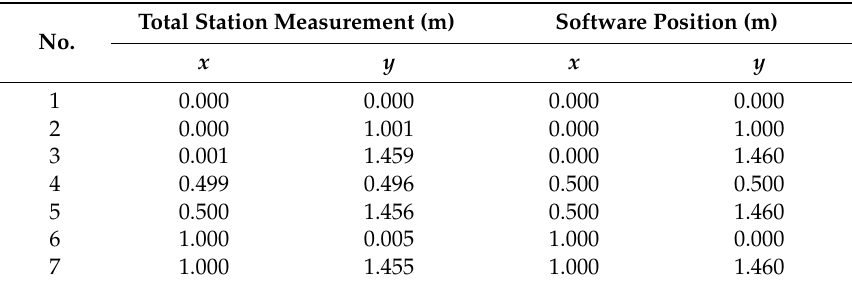
Table 1. List of the performed calibration points with